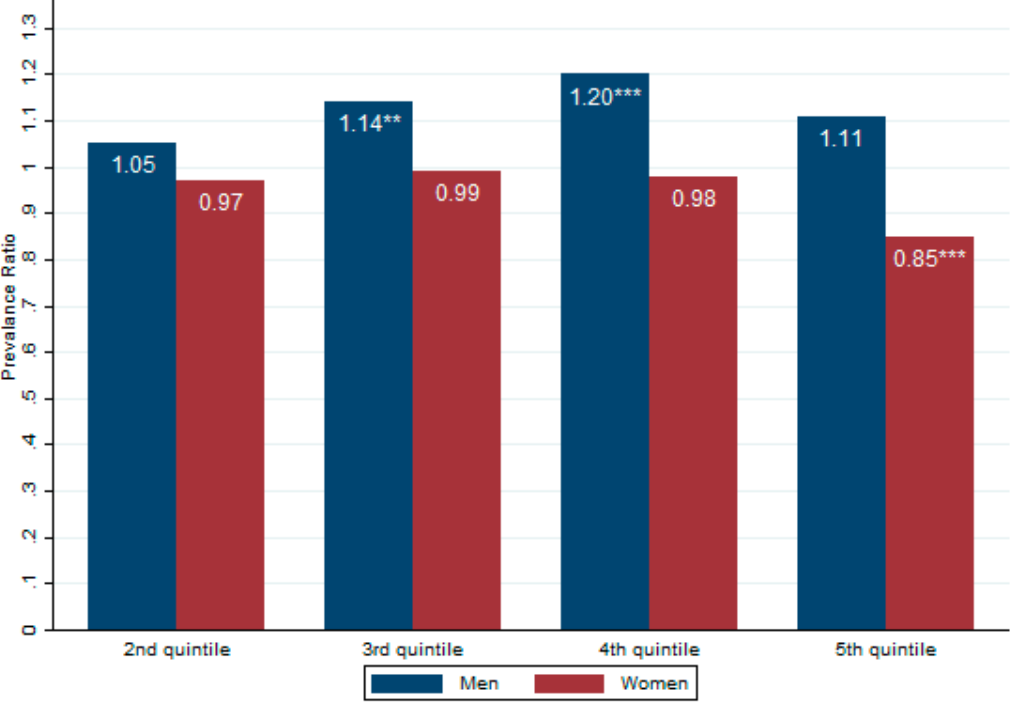
Figure 1. Association between income inequality and obesity in US men and women. Notes: Values show the prevalence ratio for adjusted model 4 and 6 (see Table 3 for more details. ** p < 0.01, *** p < 0.001.